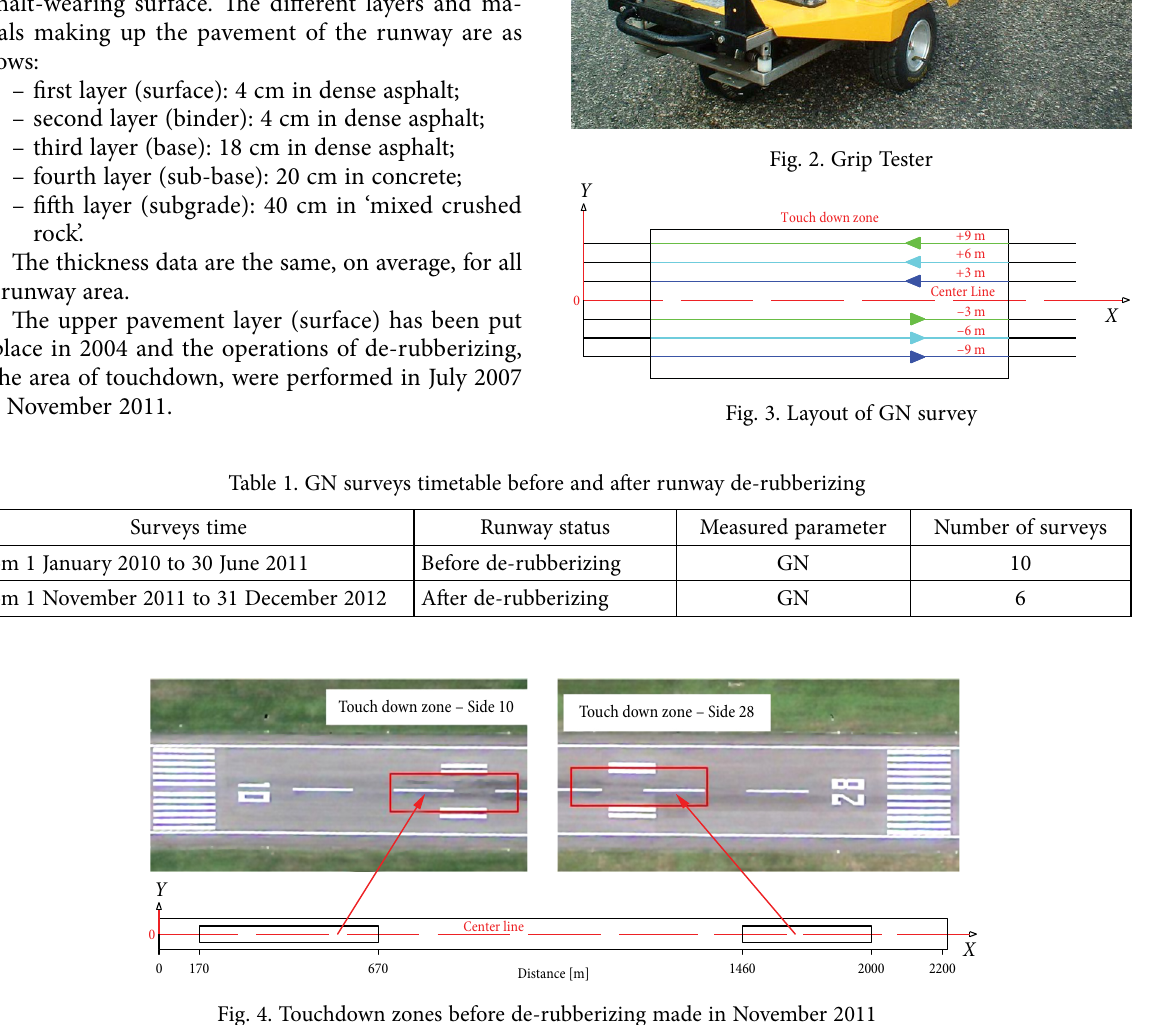
Fig. 2. Grip Tester